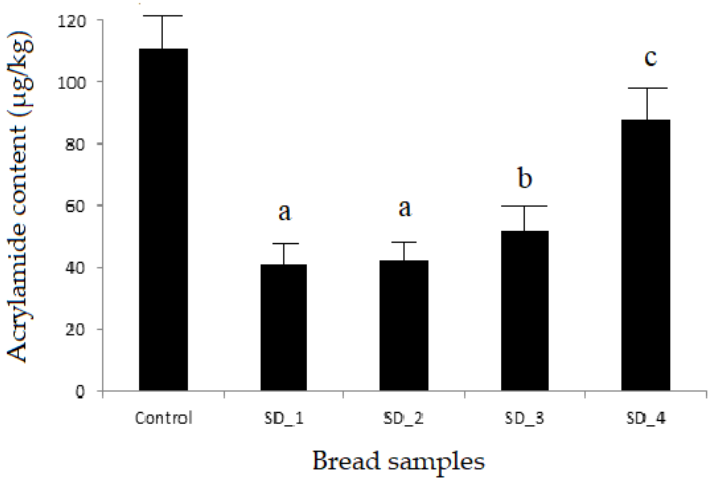
Figure 2. Acrylamide content of bread samples with different levels of dry sourdough (SD) addition. Vertical bars represent the standard errors of means. Each acrylamide content value followed by the same letter is not significantly different ( p < 0.05).